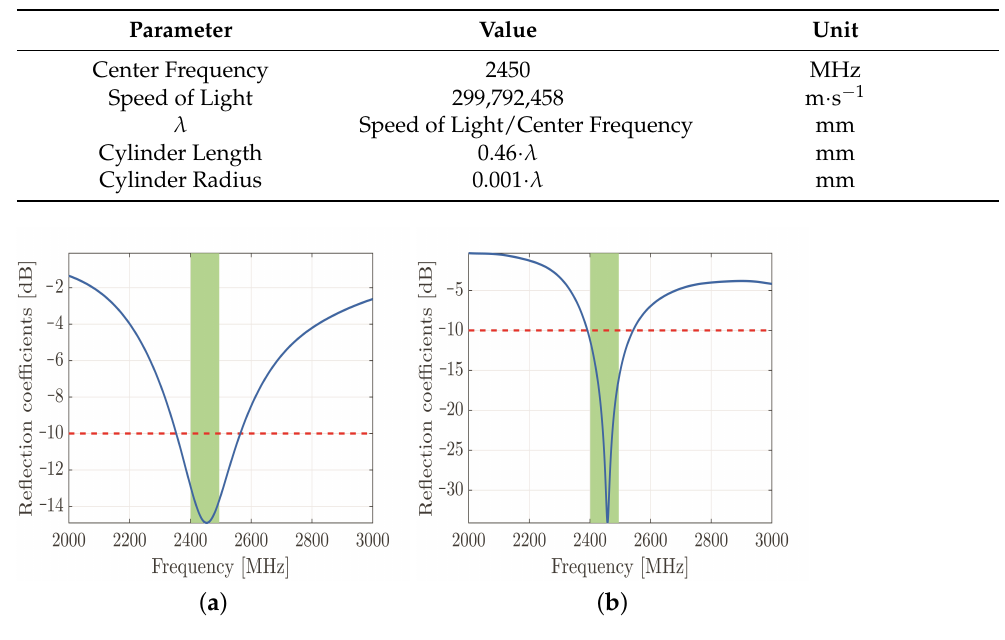
Figure 3. Simulated reflection coefficients of designed dipole antenna. The reflection coefficients are plotted along the vertical axis with the blue line, the threshold value of − 10dB is represented by the red dashed line, and the green rectangle represents the 2.45GHz frequency band of IEEE 802.11b standard ( a ). Simulated reflection coefficients of designed PIFA antenna. The reflection coefficients are plotted along the vertical axis with the blue line, the threshold value of − 10dB is represented by the red dashed line, and the green rectangle represents the 2.45GHz frequency band of IEEE 802.11b standard ( b